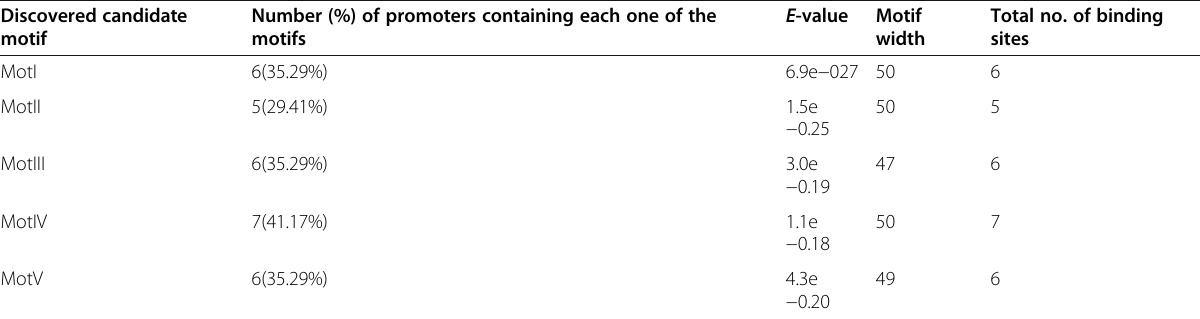
Table 2 Identified common candidate motifs in Trametes hirsuta strain 072 gene promoter regions Discovered candidate